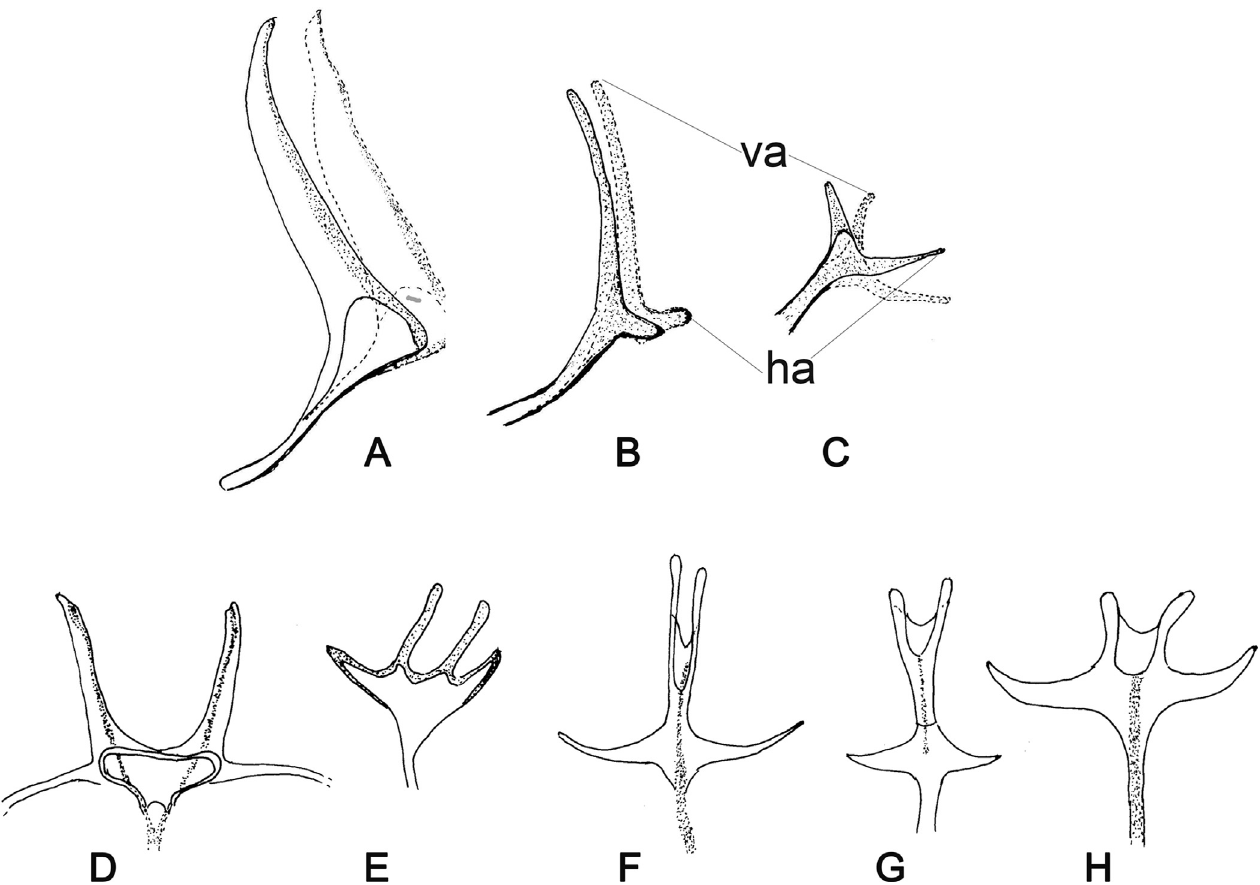
Figure 13. Metafurca of Phlebotominae: (A–C) Lateral view: (A) completely separate vertical arms and atrophied horizontal arms: Warileya phlebotomanica ; (B) completely separate vertical arms and short horizontal arms: Warileya nigrosaculla ; (C) completely separate vertical arms and long horizontal arms: Chinius samarensis . (D–H) Frontal view: (D) completely separate vertical arms and atrophied horizontal arms: Wa. phlebotomanica ; (E) completely separate vertical and short horizontal arms: Chinius eunicegalatiae ; (F) united long vertical and horizontal arms: Sergentomyia minuta ; (G) united long vertical and short horizontal arms: Bichromomyia flaviscutellata ; (H) united short vertical and long horizontal arms: Brumptomyia brumpti